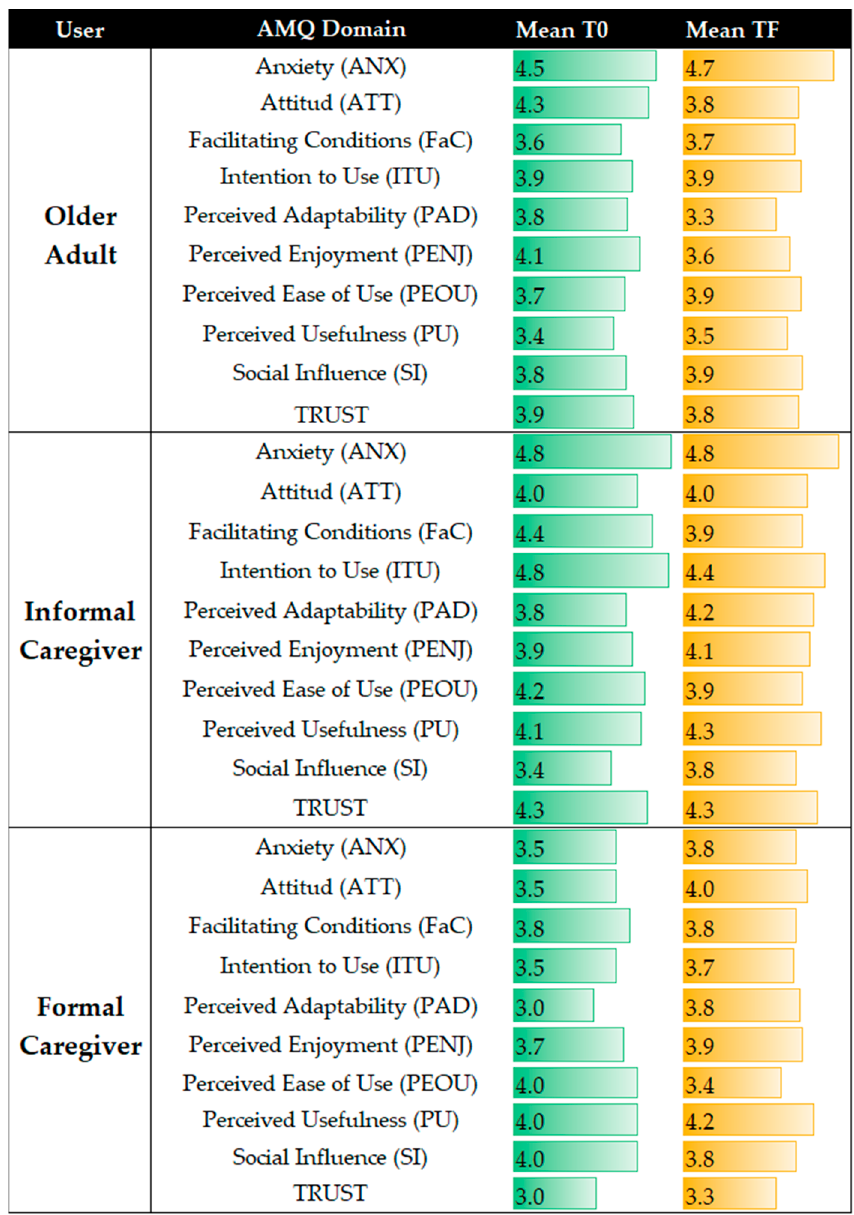
Figure 8. Differences between the averages of the AMQ results in T0 and in TF, divided by type of user and domain. The samples consist of six older adults, four informal caregivers, and two formal caregivers at T0; and seven older adults, five informal caregivers, and two formal caregivers at TF.